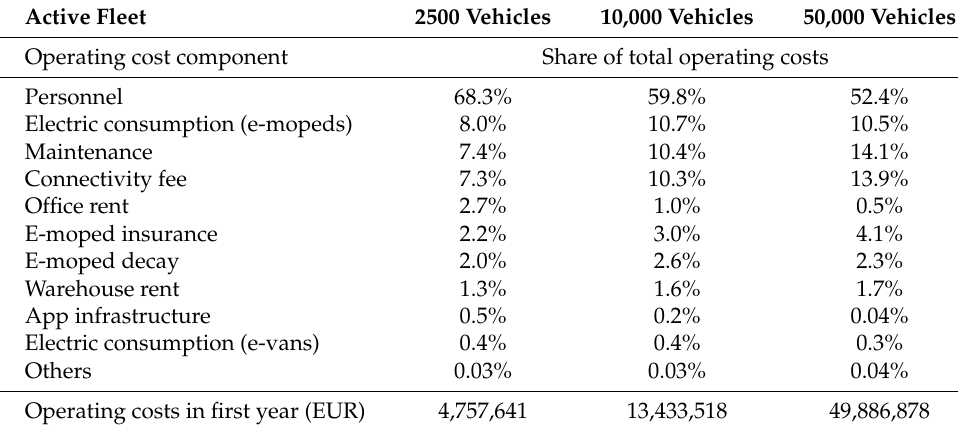
Table 4. Operating cost components for the main scenarios.